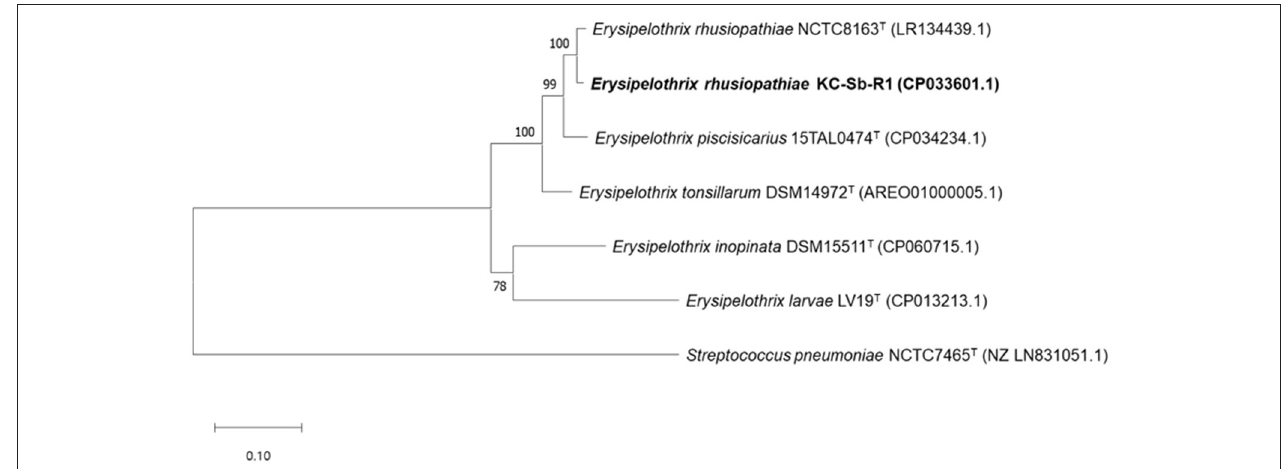
FIGURE 3 | Maximum-likelihood tree based on the nucleotide sequences of rpoB encoding the β -subunit of DNA-dependent RNA polymerase in Erysipelothrix rhusiopathiae strain KC-Sb-R1 to five other strain types of the Erysipelothrix species and the outgroup Streptococcus pneumoniae NCTC7465 T . The scale bar represents 0.1 nucleotide substitutions per